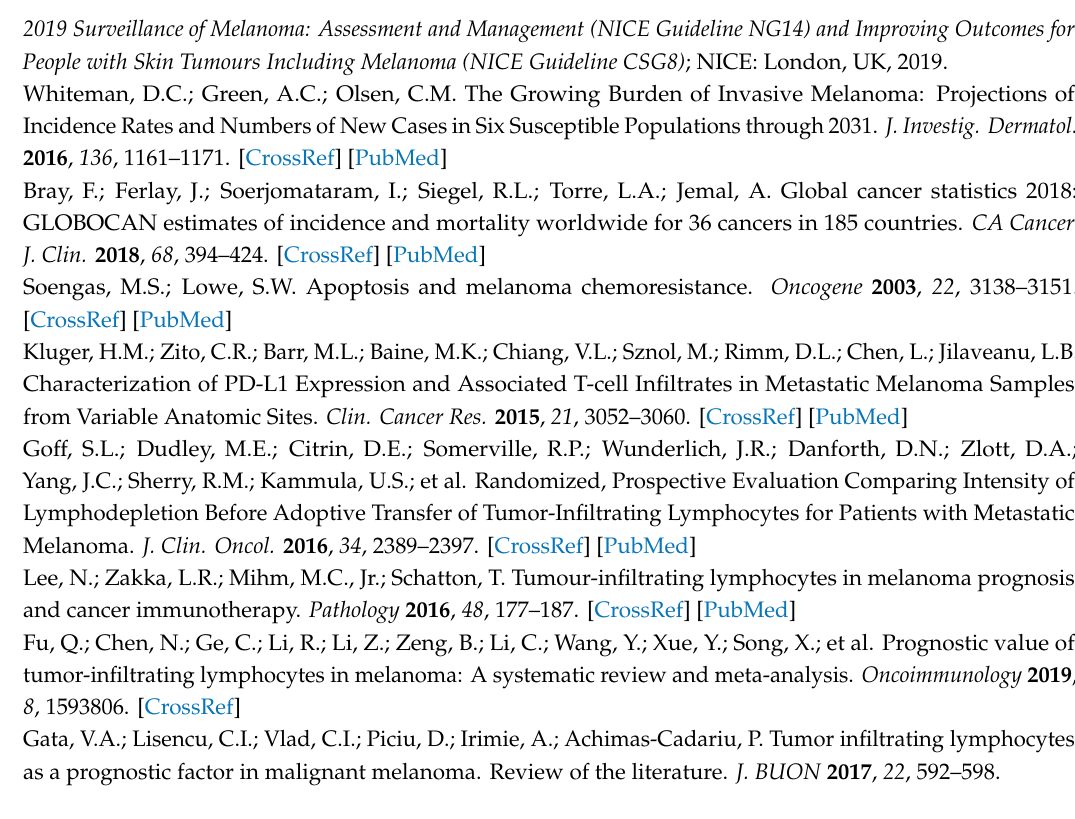
Table S1: Numbers of TCGA tumor and normal samples and their paired GTEx samples in GEPIA. Table S2: COX regression results for Ly75 with TCGA data in various types of cancers by OncoLnc (http: // www.oncolnc.org / ), Table S3: Correlation analysis between Ly75 and infiltrated immune cells in